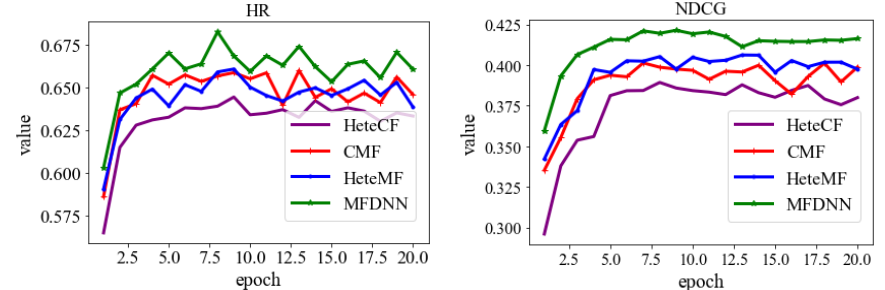
Figure 16. The HR and NDCG values for the MFDNN and HIN-based baseline methods .